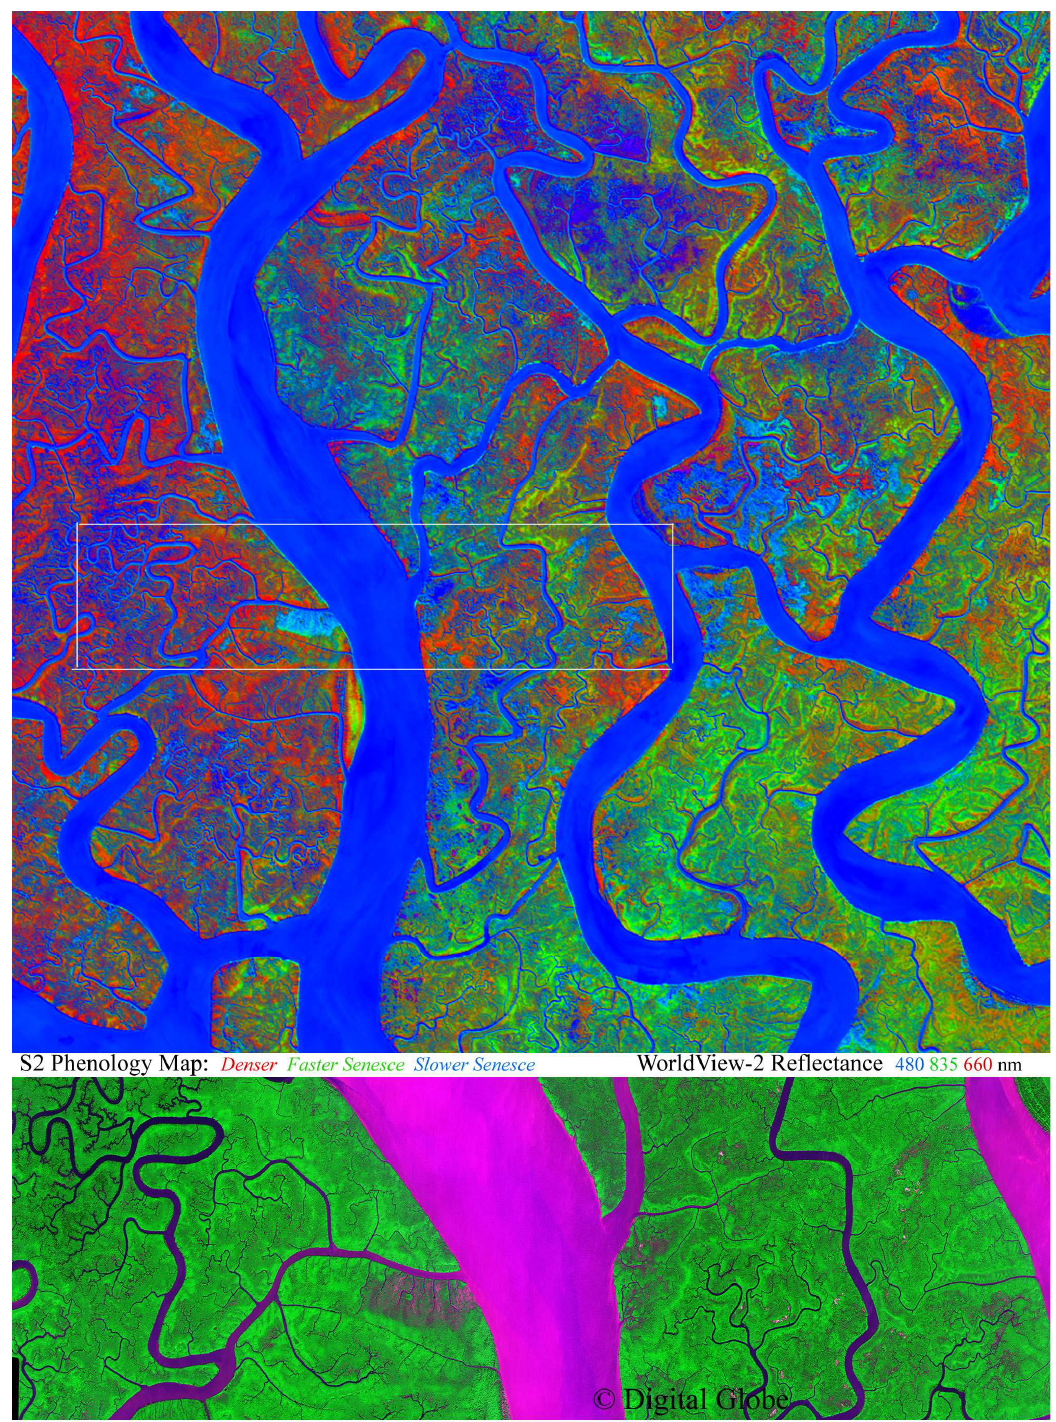
Figure 8. Temporal feature space and PC map of 10 × 10 km substack from Fig. 4. The PC map shows spatially coherent structure resulting from distinct combinations of PCs 1–3. The feature space (bottom) clearly separates water from forest, spanning 3 distinct senescent phenologies at apexes of PC 3/2 space.